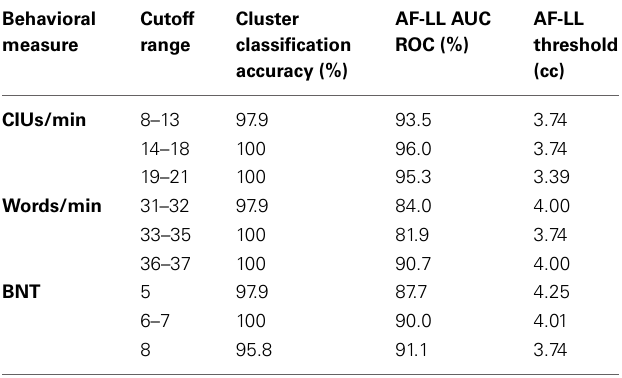
Table 3 | Range of behavioral cutoffs for speech fluency and ROC prediction.